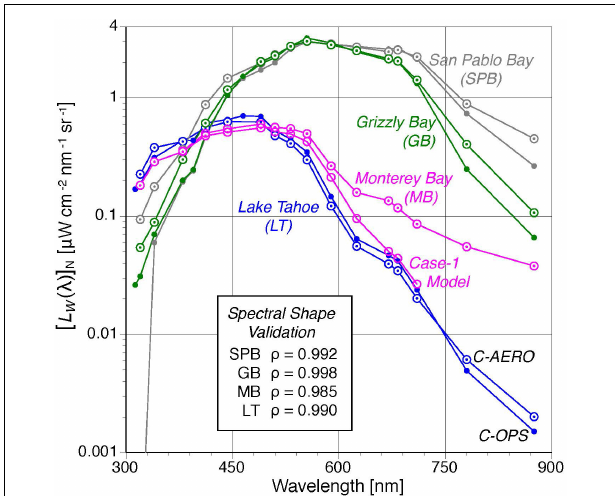
FIGURE 8 | C-AERO was validated using in situ data obtained with a C-OPS equipped with digital thrusters (C-PrOPS) except in Monterey Bay (30 Hz L T data), wherein a case-1 model was used. The matchups between C-AERO and C-OPS are based on minimizing the distance between the two sampling sites. For the Monterey Bay comparison, the TChl a concentration obtained at the Santa Cruz Wharf was used to derive the case-1 model results and compared to the spatially nearest C-AERO observation. The correlations ( ρ ) in spectral shape for each site are provided, demonstrating excellent retrieval of spectral information from the airborne